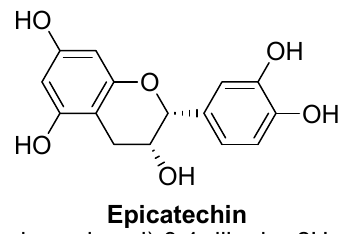
Figure 43. Epicatechin.